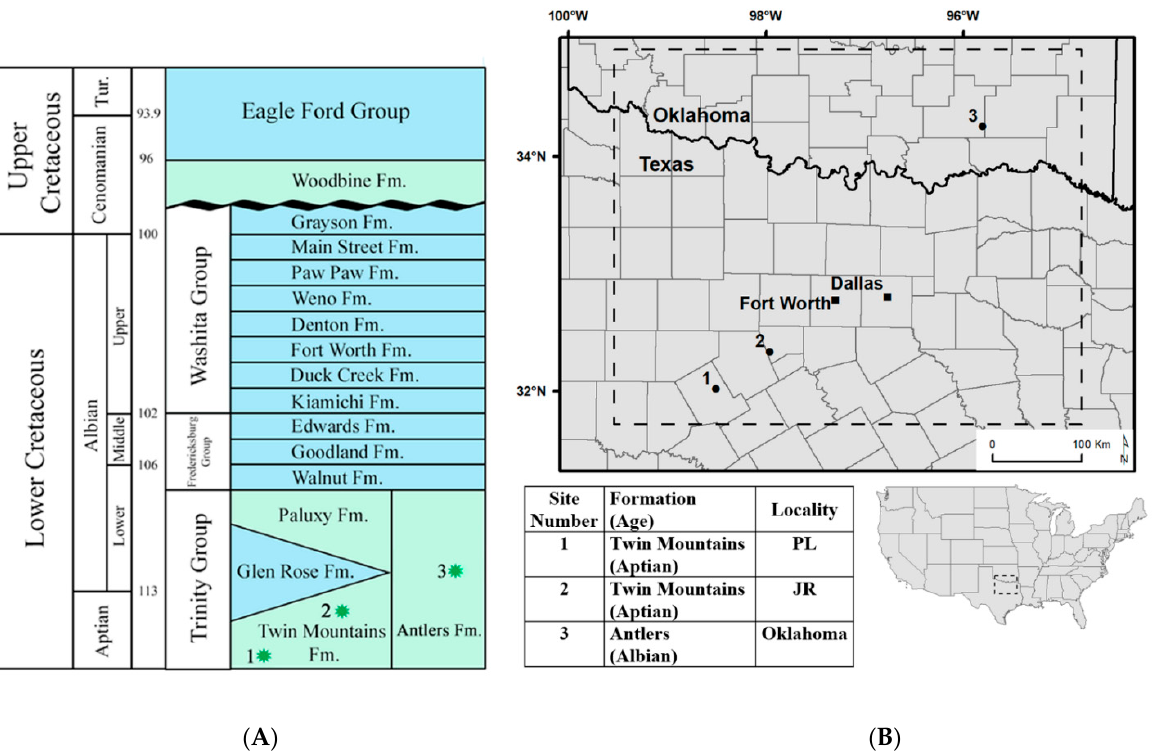
Figure 1. Regional stratigraphic column and map of study area: ( A ) lithostratigraphic units spanning the Early to Late Cretaceous interval of North Central Texas and southern Oklahoma (modified from Jacobs and Winkler, 1998); ( B ) a map displaying the study area with localities correlating to the site number listed with collected samples: 1 = Proctor Lake locality (PL), 2 = Jones Ranch locality (JR), 3 = Oklahoma locality.